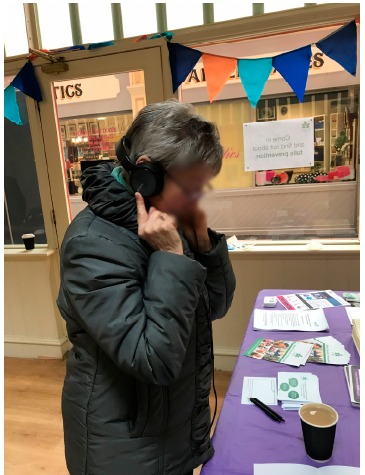
Figure 2. Listening to the audio statements.